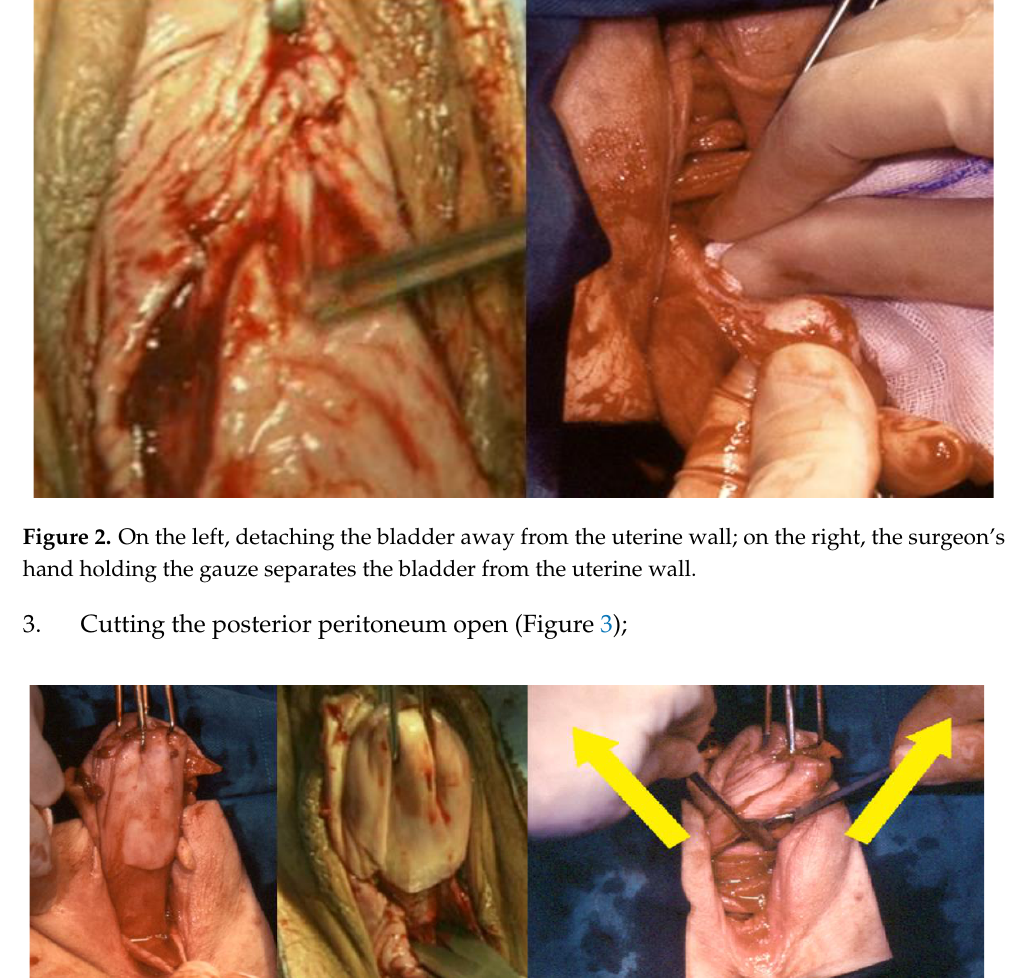
Figure 4. On the left, the lower part of the Heaney clamp is placed under the Sacro-Uterine ligament, grasping the Utero-S acral ligaments; on the right, while rotating the uterus clockwise (in the left